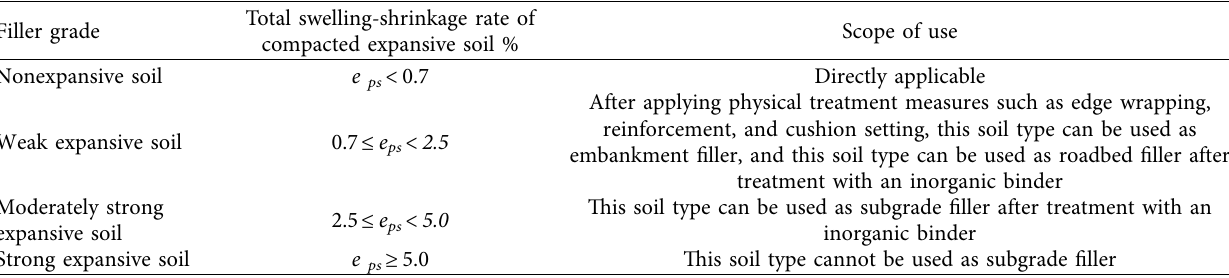
Table 2: Classification of the expansion potential of expansive soil.